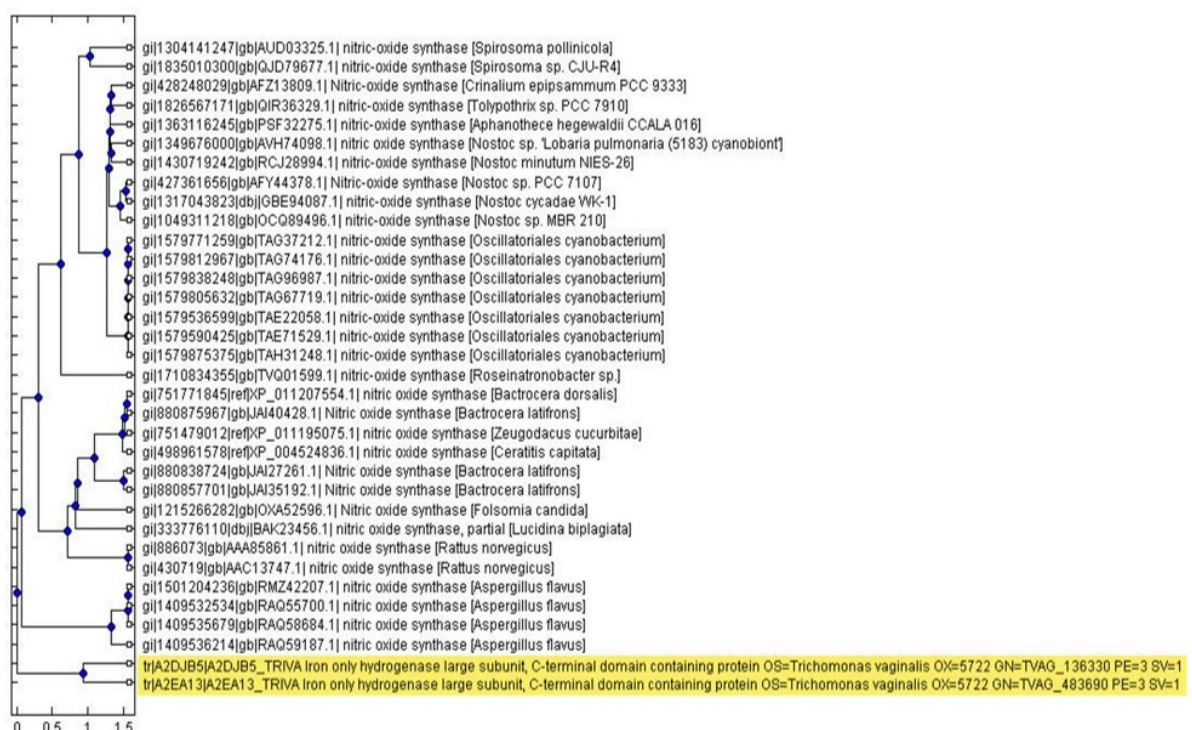
Table 1. Prediction of the 3D model of TV NOS in RoseTTAFold and AlpaFold2. Both proteins have no close homologs in the Protein Data Bank (PDB).